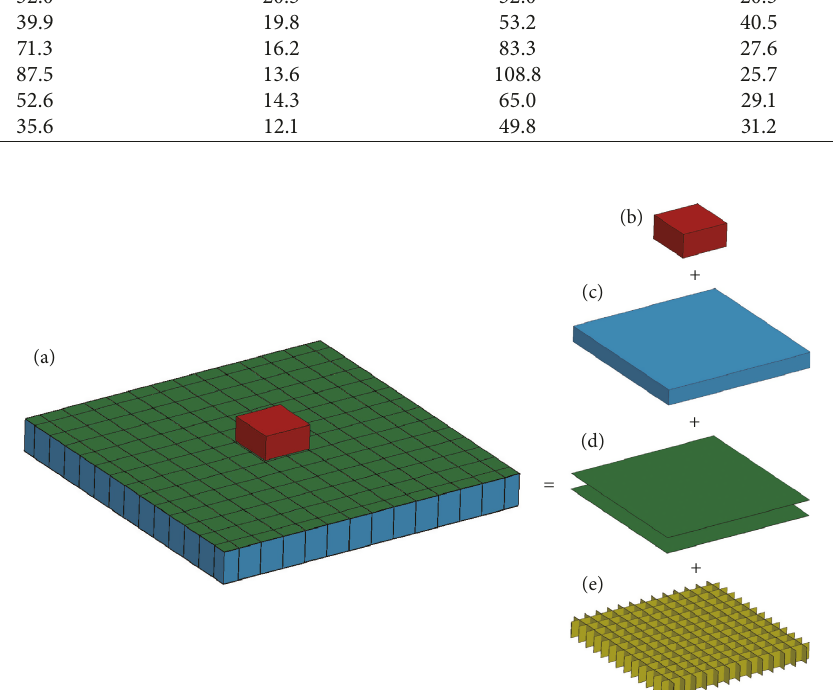
Figure 10: Model geometry: (a) specimen TS75-100; (b) rigid loading cell; (c) PU foam core; (d) face sheets; (e) lattice